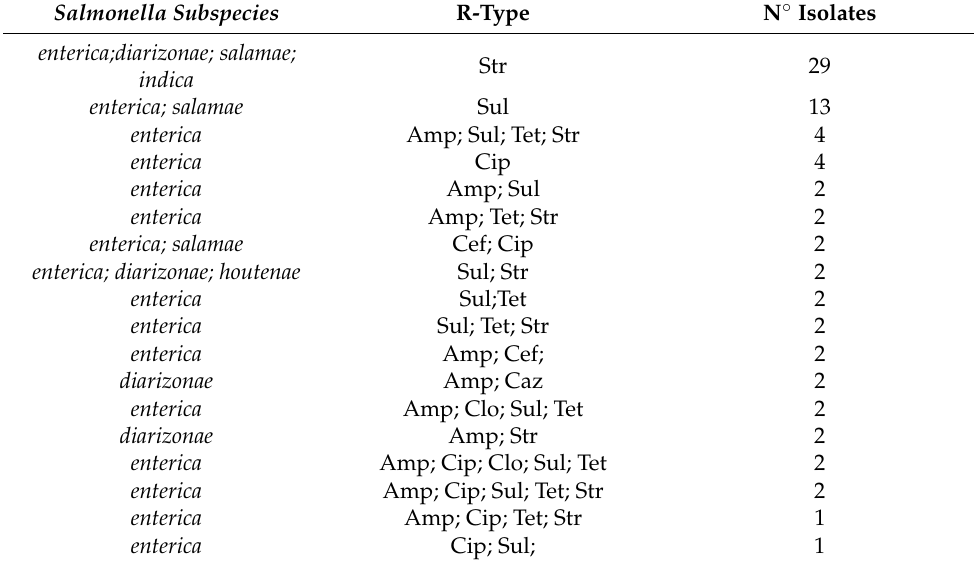
Table 4. Occurrence (n.) of resistance profiles observed within the subspecies enterica, diarizonae , salamae , houtenae , S . arizonae and indica isolated from wildlife and the environment.